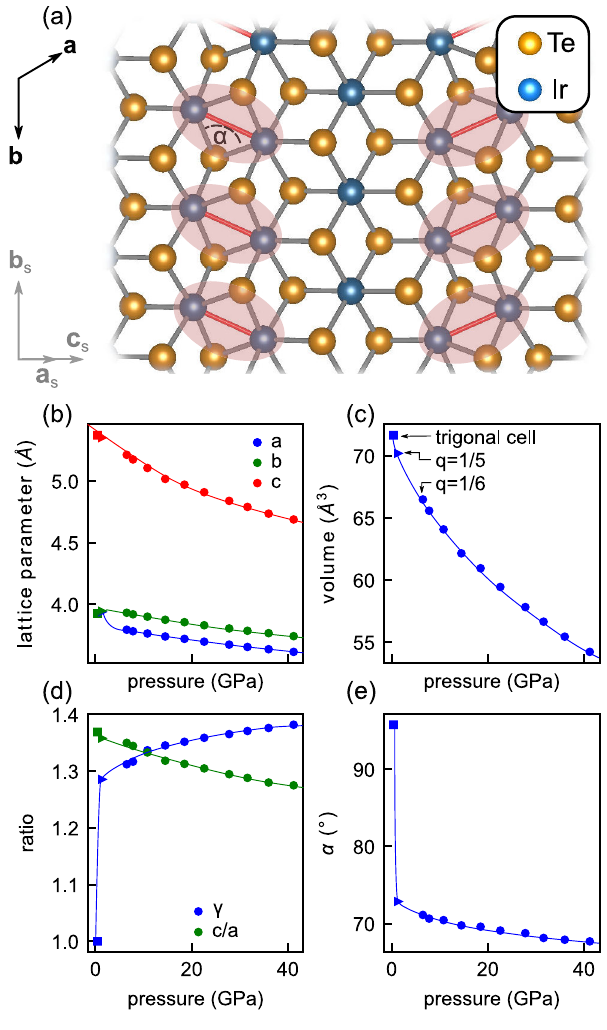
Fig. 4 Structural parameters as determined from the single crystal data as a function of pressure. a Sketch of one Te-Ir-Te layer in the q = 1/ 6 structure. The short Ir-Ir distances inside the dimers are highlighted in red. All parameters in ( b – e ) are derived from a transformation of the supercell back to an approximately trigonal cell. The corresponding (pseudo)-trigonal in-plane lattice vectors a and b are indicated as black arrows. The lattice vectors corresponding to the monoclinic q = 1/ 6 structure ( a s ; b and c s ) are shown in gray. Note that the in-plane s directions in terms of the monoclinic cell are given by a s + c s and b s . b , c The (pseudo)-trigonal lattice parameters and cell volume as a function of pressure. d c / a -ratio (green) and the ratio between long and short Ir-Ir bonds γ = d l / d s (blue). e Ir-Te-Ir angle α as indicated in ( a ). Error bars in ( b – e ) are smaller than the symbol size. Square, triangular and circular symbols correspond to data from the trigonal, triclinic q = 1/5- and monoclinic q = 1/6-phase. Solid lines are guides to the